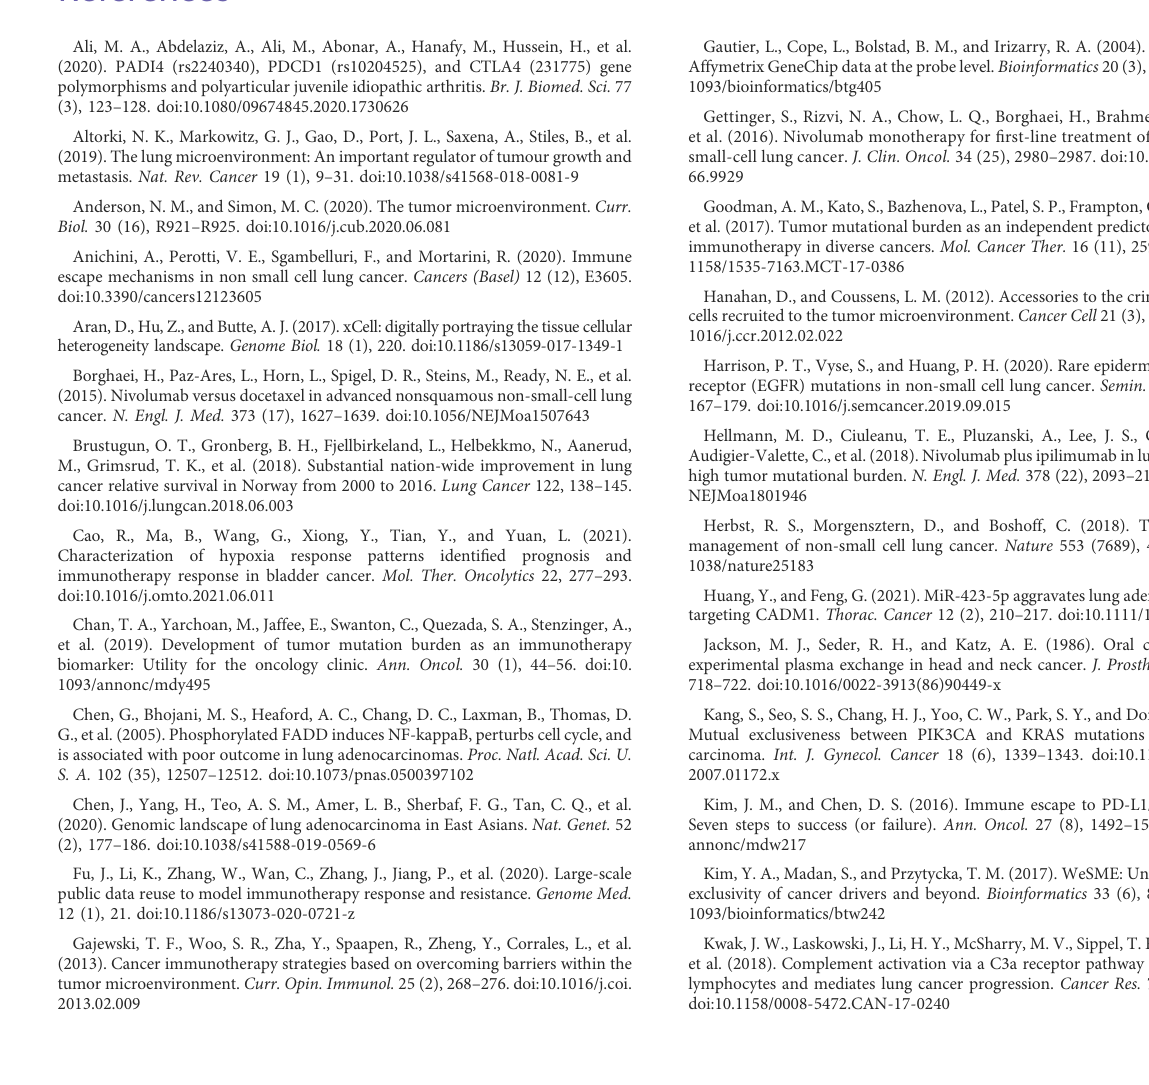
SUPPLEMENTARY FIGURE S1 The immune in fi ltration of TPS